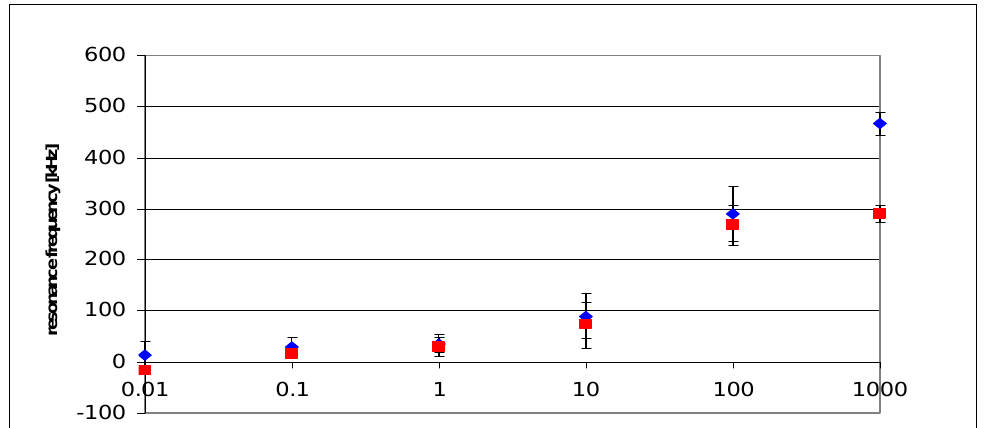
Figure 6. Titration curve for hybridisation of a CALCA PCR product in buffer (  ) and serum (  ) (1:100) with a surface layer of S-S-CALCA/Lipa-DEA. The error bars show the standard deviation over 4 pixels. All points were recorded on the same